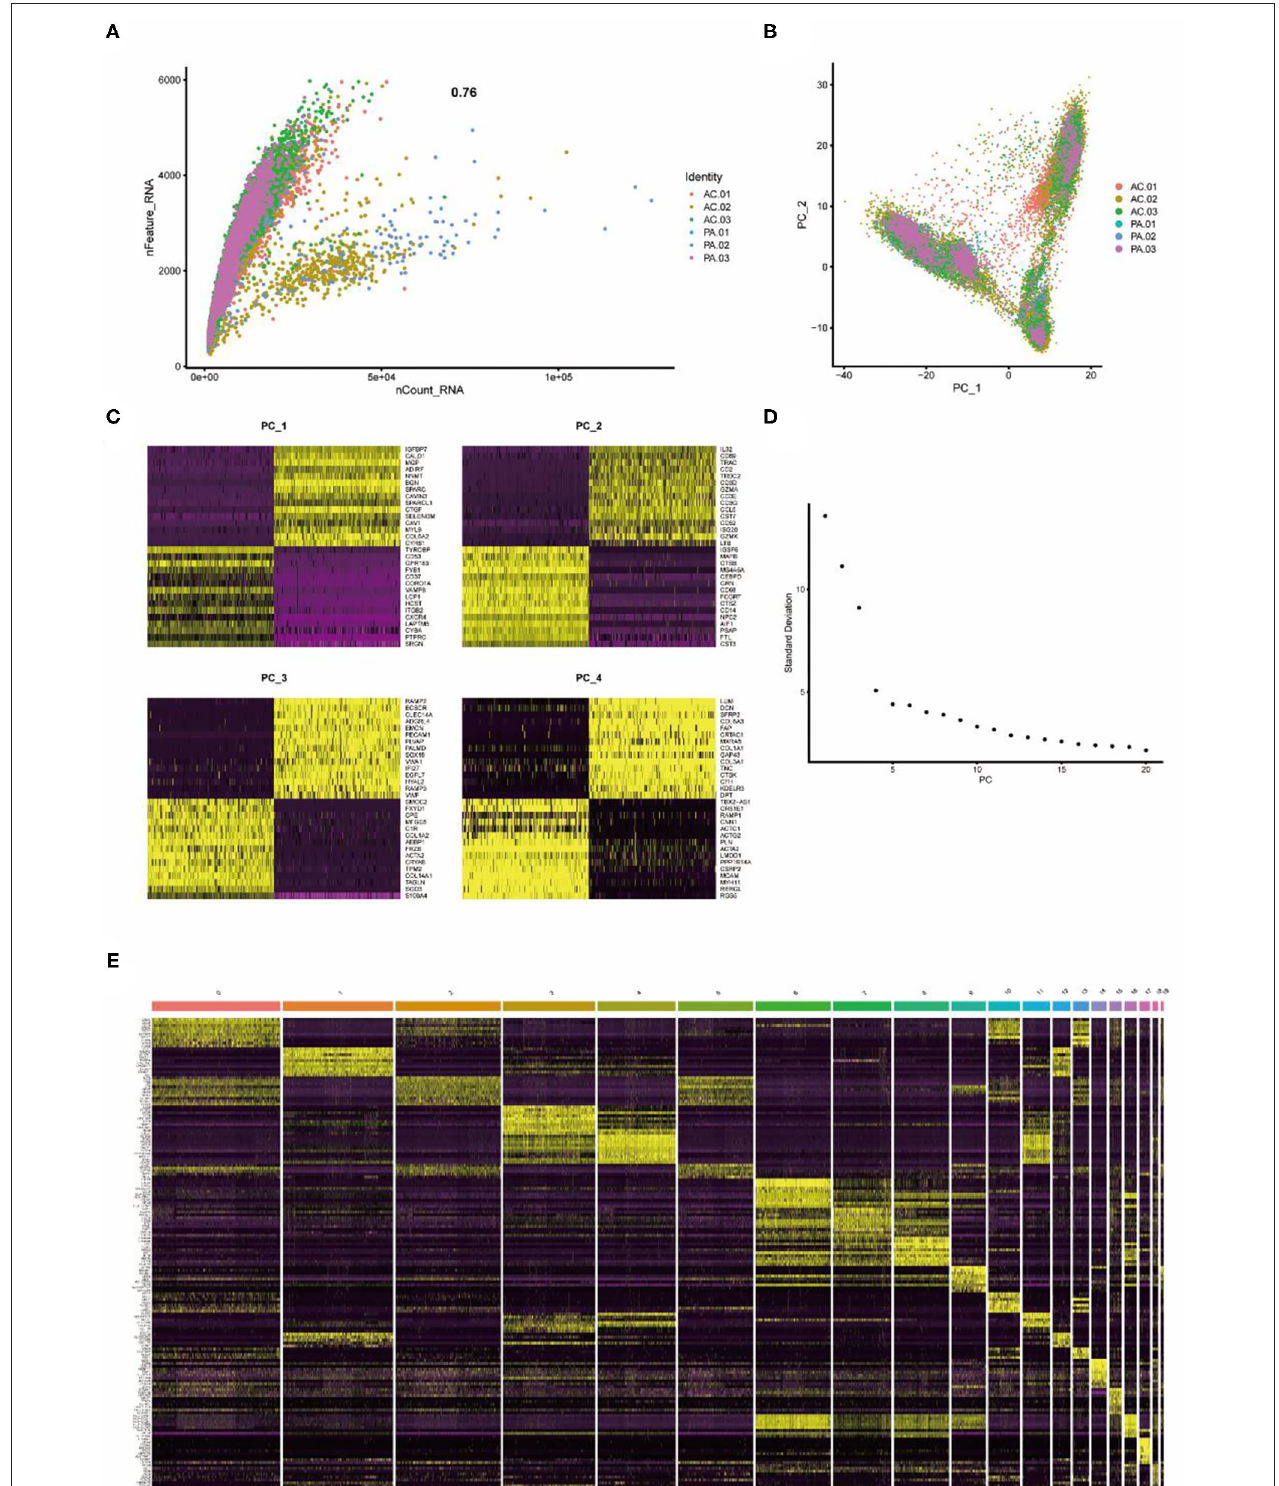
FIGURE 1 | Twenty clusters identified based on single-cell RNA-Seq data reveal multiple cell subpopulations in calcified plaques. (A) The number of genes detected correlates significantly with the depth of sequencing. (B) PCA showing separation of cells in calcified plaques. (C) Differential genes in the first 4 PCs. (D) PCA identifies 20 PCs. (E) Differential analysis identifying the top 10 marker genes for each cell cluster is shown in the heat map. From yellow to purple indicates gene expression levels from high to low.